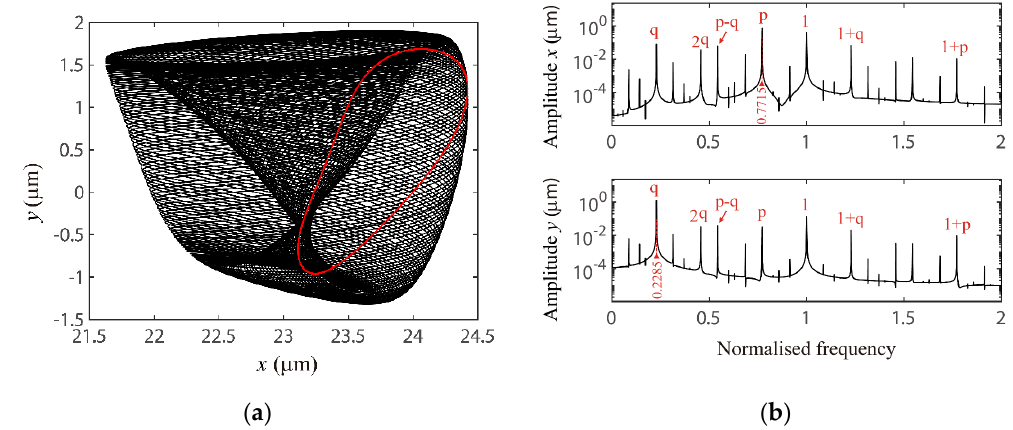
Figure 31. Response characteristics of the VC quasi-period motion when Ω = 242.2277 rad/s (i.e., in literature [14], ω s takes 6000 rpm), ( a ) orbit (black line) and its Poincare mapping (red dots), ( b ) frequency spectrum.